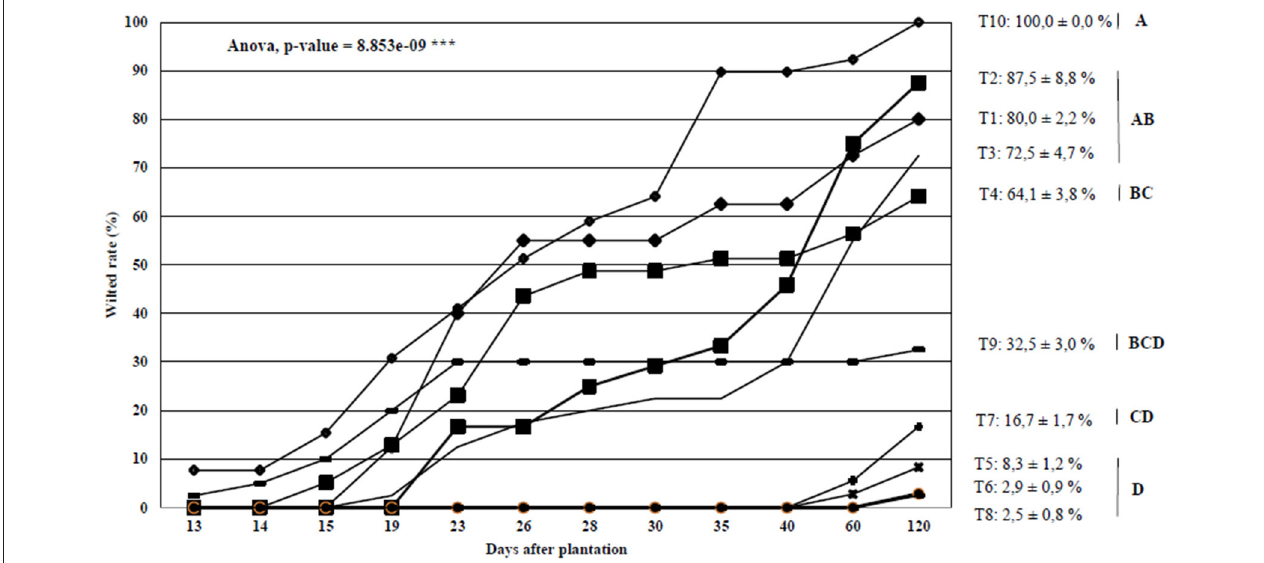
FIGURE 3 | Bacterial wilt progression curves on 10 Core tomato accessions screened under field conditions at the Dembeni experimental station during the 2011 hot and wet season. Means and standard errors are shown. Homogeneous groups were created transforming wilted datas with arcsin square root function and performing variance analysis followed by a Tukey’s HSD